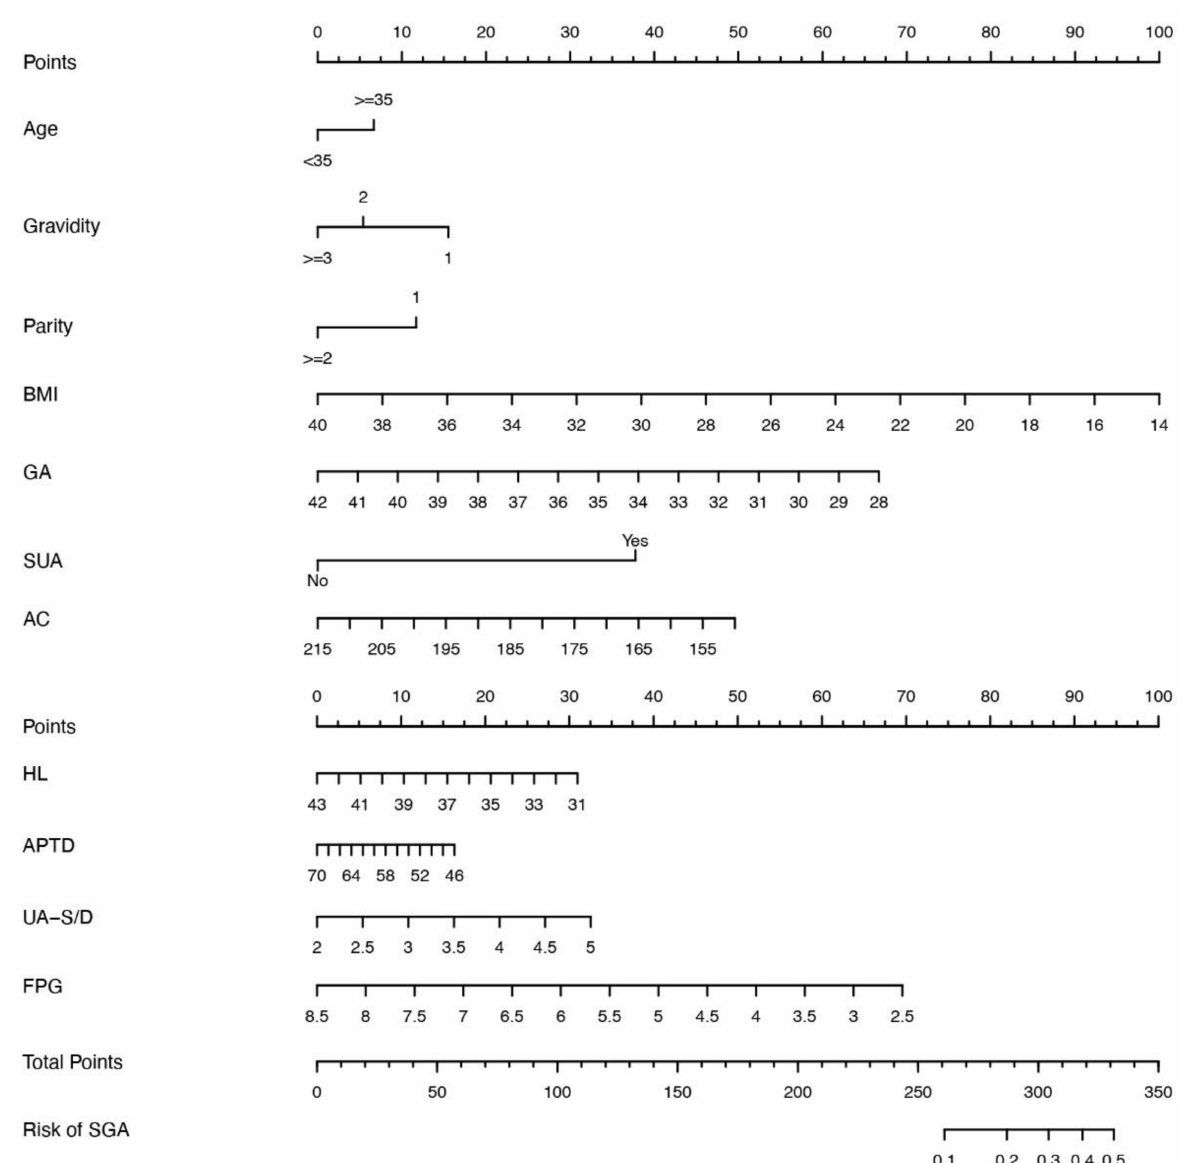
Figure 2. Nomogram model for predicting the risk of small for gestational age in the mid-trimester pregnancy. BMI, body mass index; GA, gestational age; SUA, single umbilical artery; AC, abdominal circumference; humeral length APTD, anteroposterior trunk diameter; UA-SD, Umbilical artery systolic/diastolic ratio; FBG, fasting blood glucose; SGA, small for gestational